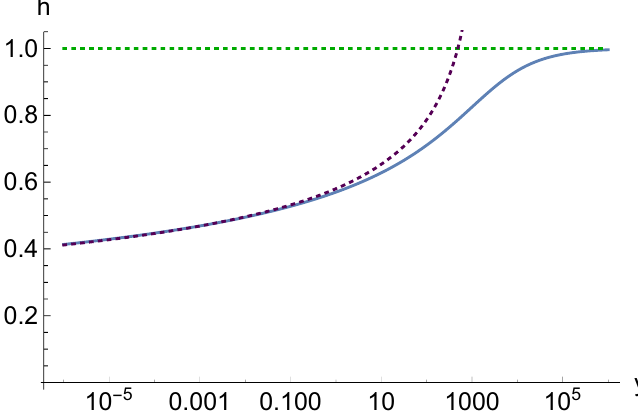
Figure 21 . The function h ( y ) as the solution of eq. (B.28) is shown as a solid line. The green and purple dotted lines correspond to 1 and (3 = log(98304 (cid:25) 6 =e 3 y 2 )) 1 = 3 , and show the behaviour of h ( y ) for small and large y ,